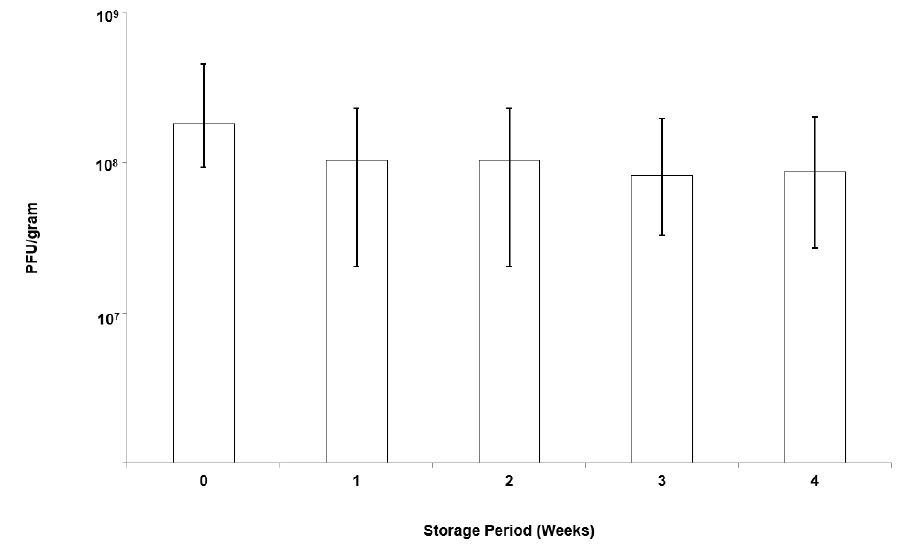
Figure 9. Storage stability of K1F phages in EK1F microparticles refrigerated at 4 ° C: Phage titre was evaluated by exposing microparticles to SIF.